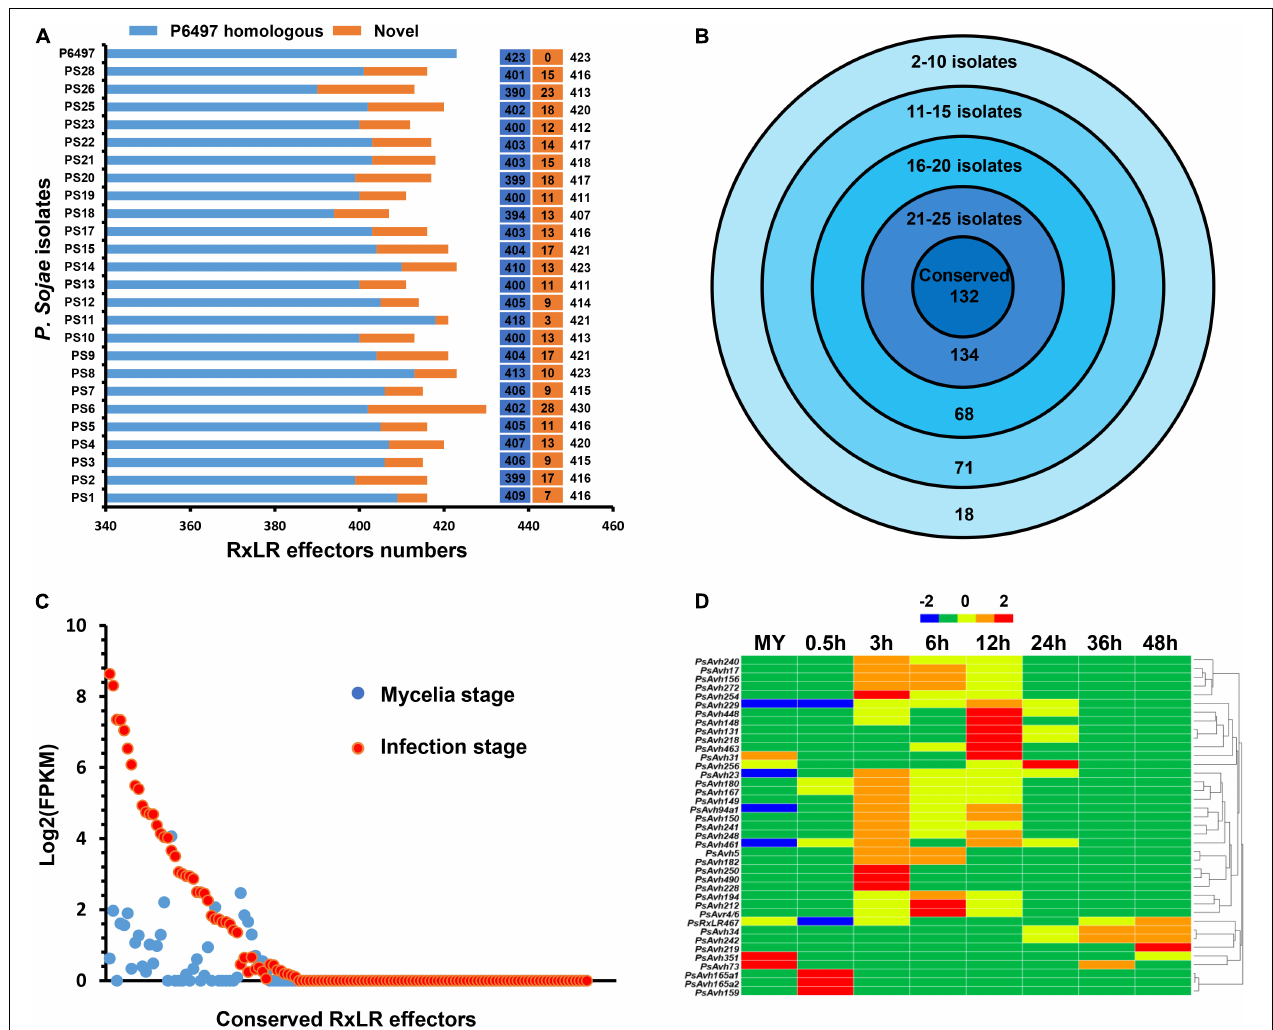
FIGURE 5 | The RxLR effector repertoire in P. sojae . (A) Number of RxLR effectors predicted in 26 P. sojae isolates. Blue color indicates homologs of known RxLR effectors. Yellow color indicates predicted novel RxLR effectors. (B) Distribution of RxLR effectors across 26 P. sojae isolates. Number of species in which certain effectors were exclusively found is indicated at the outermost circle, and number of effectors in the set is indicated at the bottom. The innermost circle represents conserved effectors found in all 26 P. sojae isolates. (C) The FPKM values in mycelia and highest FPKM values at infection stages of 132 conserved RxLR effectors. (D) Hierarchical clustering of the transcriptional patterns of 42 core RxLR effectors in P. sojae . Z score normalization was applied for the transcription levels at various stages.